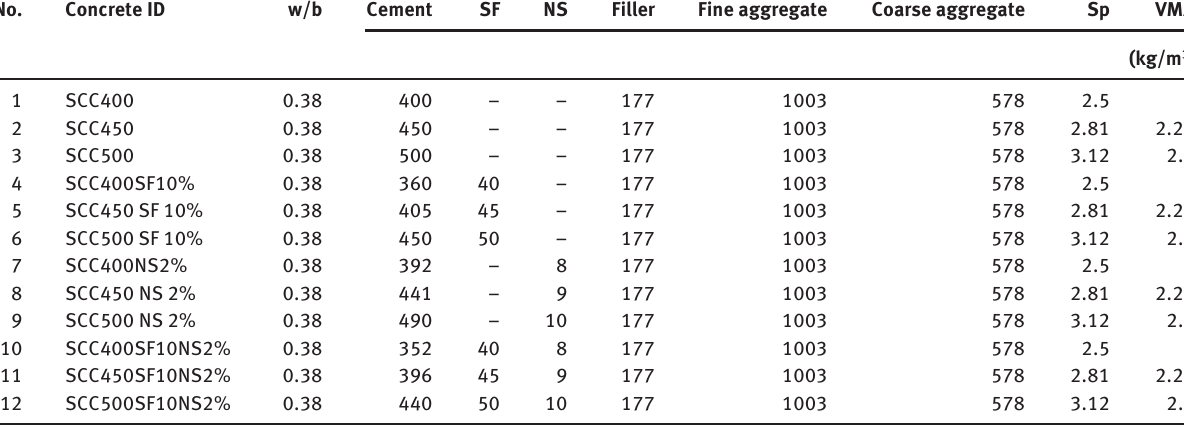
Table 3 Mix proportions of the concrete